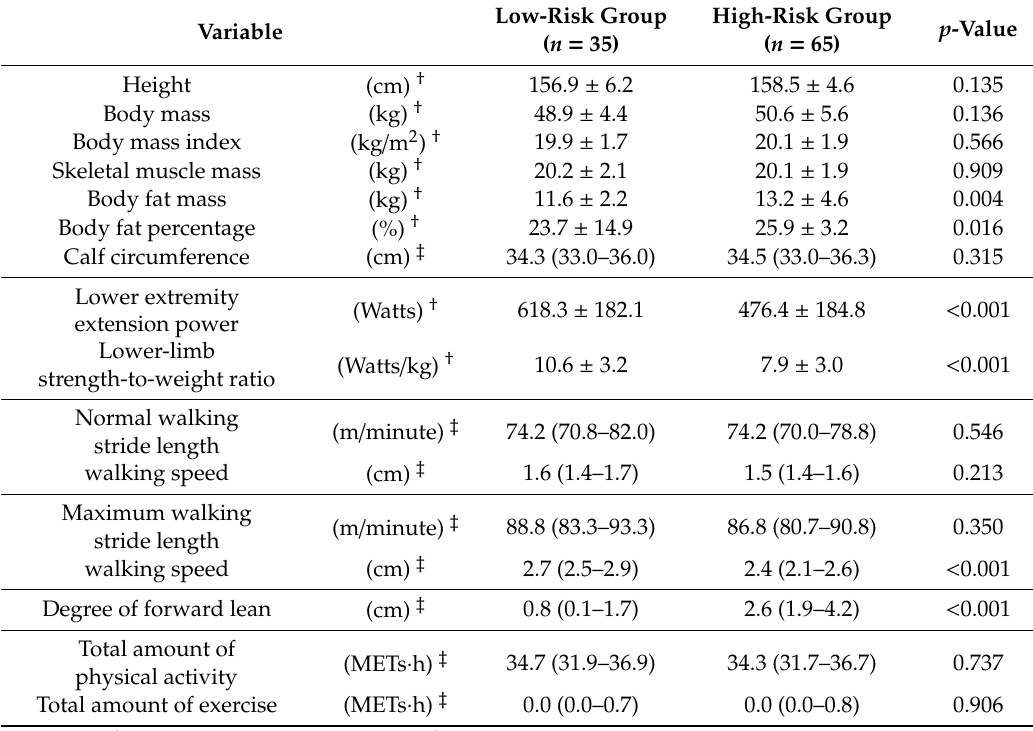
Table 2. Comparison of physical composition, physical fitness, gait function, posture, and physical activity by locomotive syndrome risk group.